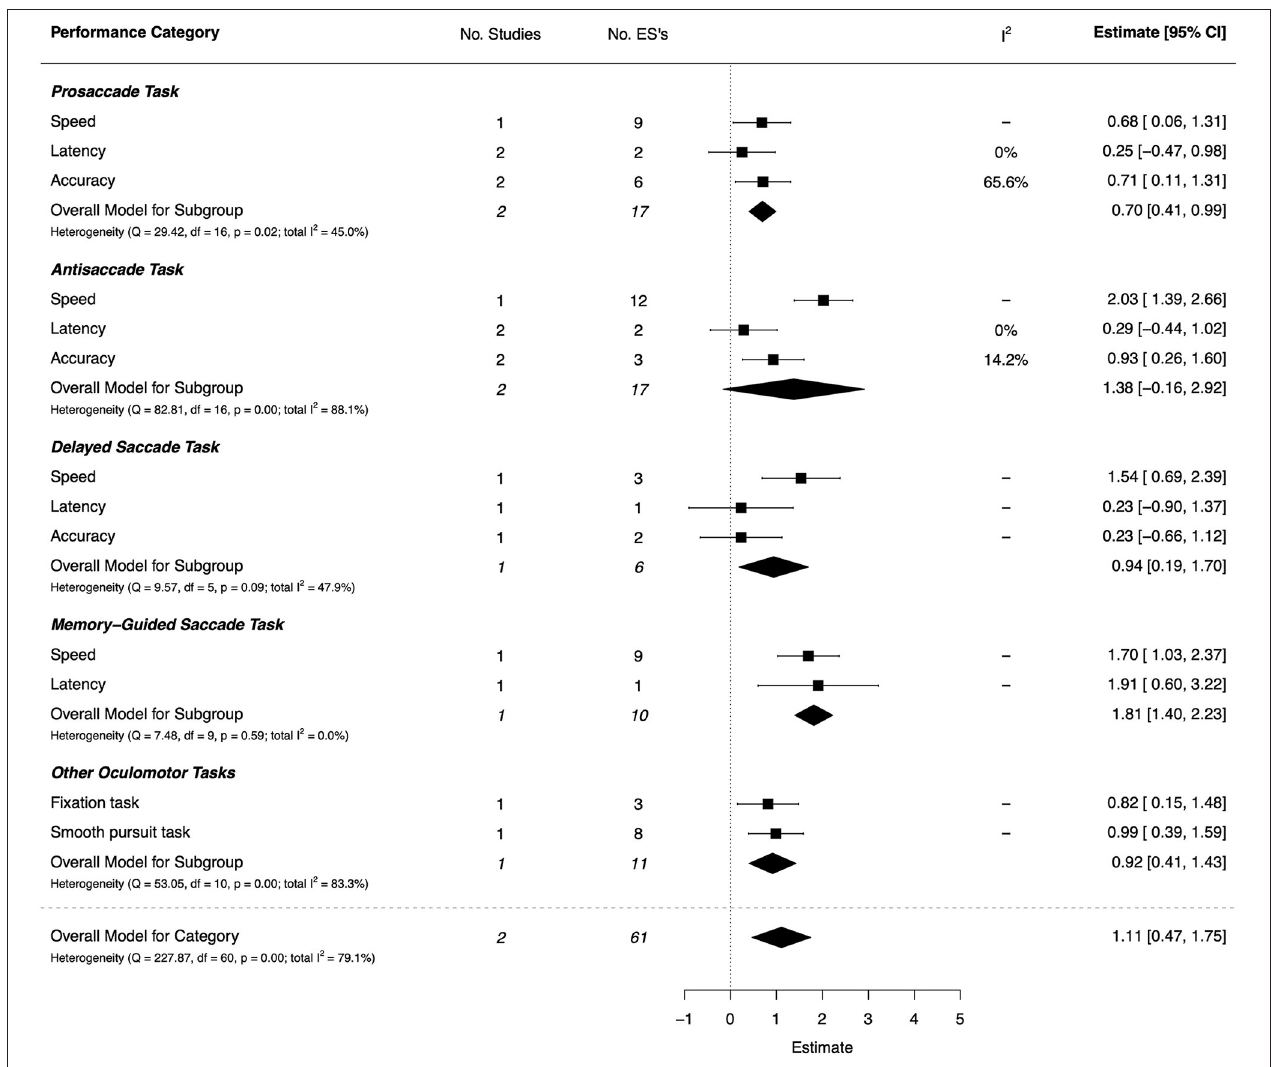
FIGURE 7 | Forest plot showing the meta-analysis results for the oculomotor control performance category.